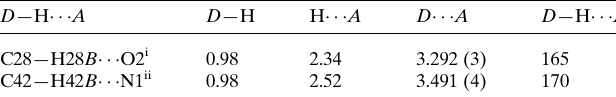
Table 1 Hydrogen-bond geometry (A˚ , (cid:3) ).